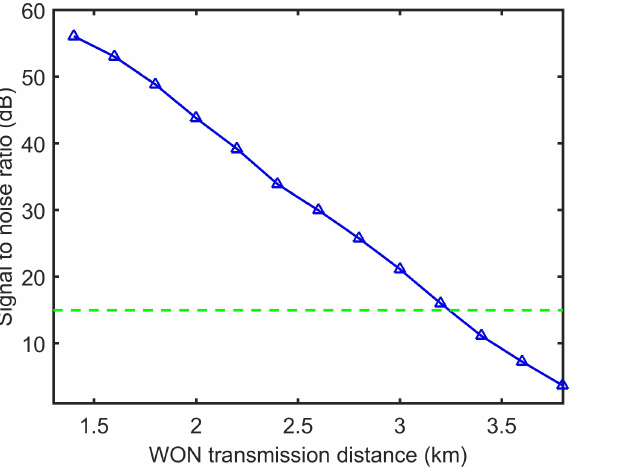
Figure 4. Example of SNR of the received signal from sensing none N2 as a function of transmission distance. The green line is the detectability limit.